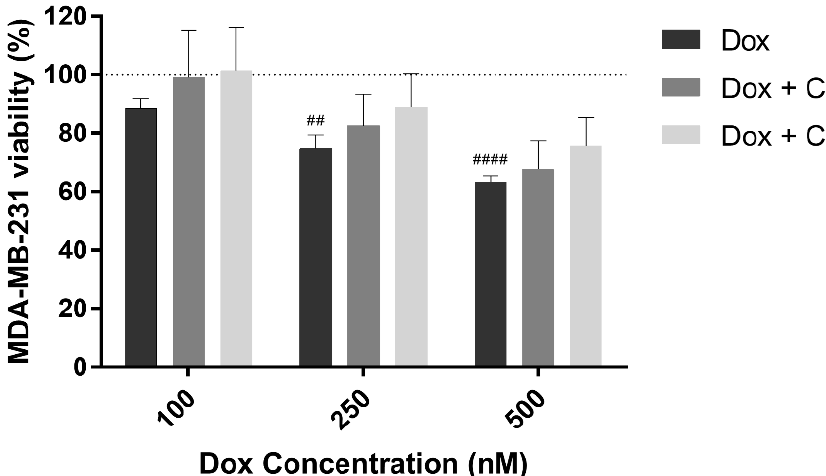
Figure 2. Exposure of MDA-MB-231 cells to MSC CM did not significantly affect the cytotoxic effect of Dox. MDA-MB-231 cells were incubated with 0–500 nM of Dox and both conditioned media, CM2D or CM3D, and cytotoxicity was evaluated by MTS reduction assay. Cell viability is expressed in percentage (mean ± SD, n = 3–6) to non-treated MDA-MB-231 cells (control). Grid line represents 100% cell viability (control). Statistical significance is expressed relative to control of non-treated cells, i.e., 100% viability as ## p < 0.01, #### p < 0.0001. CM2D, conditioned medium derived from 2D cultures; CM3D, conditioned medium derived from 3D cultures; Dox,